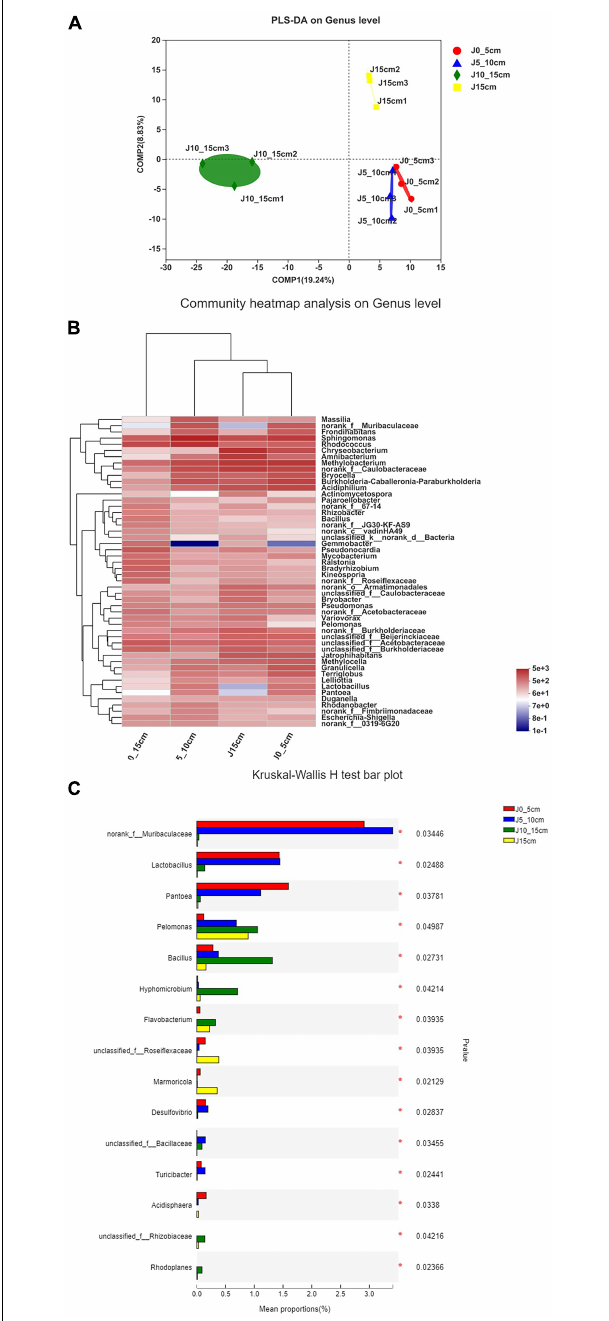
FIGURE 5 | Differences among samples in different samples on genus level. (A) Partial least squares discriminant analysis illustrates differences between bacterial communities in four groups. (B) Heatmap of top 50 most abundant genera in bacterial communities detected in four groups. Dendrograms for hierarchical cluster analysis grouping genera and sample locations were shown at left and top, respectively. (C) Kruskal–Wallis H -test bar plot of genera with a high relative abundance and statistically significant differences. *0.01 < P ≤ 0.05 (group J0_5cm represents length of stems was from 0 to 5 cm; group J5_10cm represents length of stems was from 5 to 10 cm; group J10_15cm represents length of stems was from 10 to 15 cm; group J15 cm represents length of stems was longer than 15